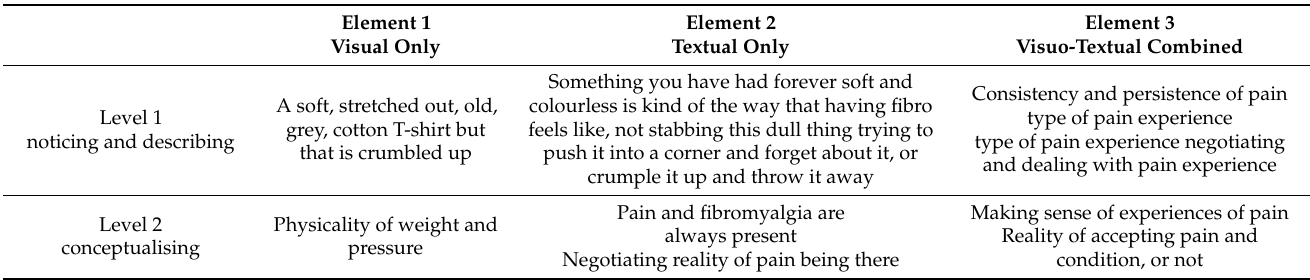
Table 4. Example of Systematic Visuo-Textual Analysis applied to Sian’s